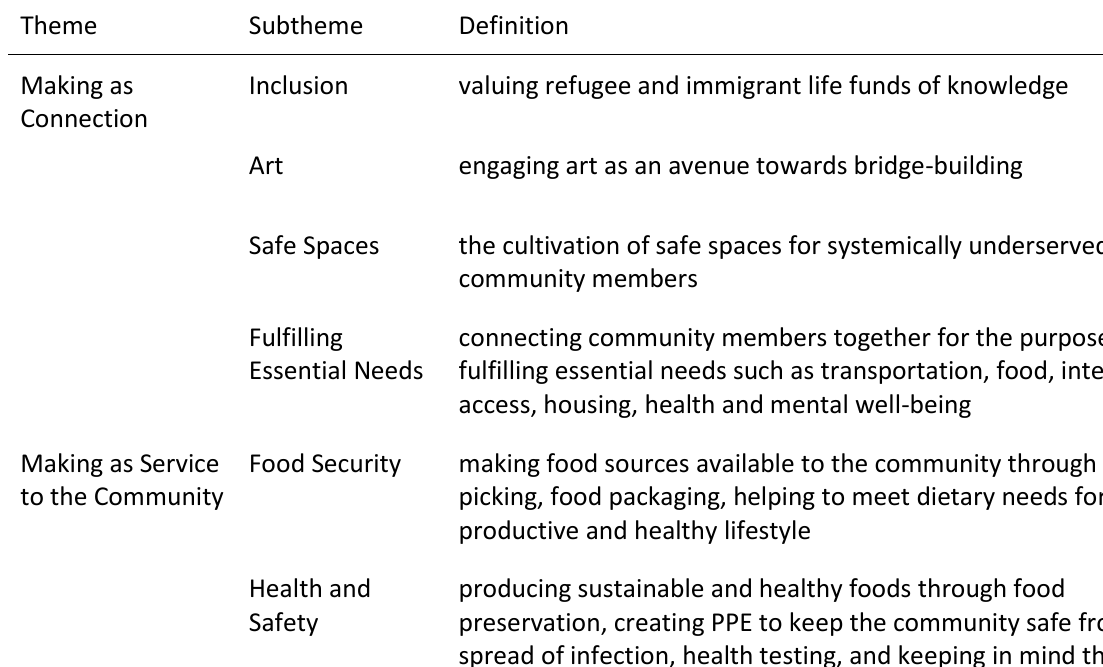
Table 2: Research Question Two’s Themes, Subthemes, and Definitions